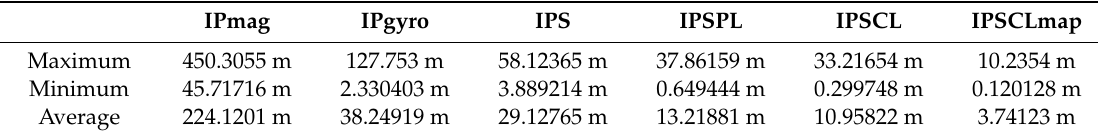
Figure 6. ( a ) Distance error for the ground-truth reference path as a function of the path; ( b ) cumulated distance error for the ground-truth reference path. Table 2. Maximum, minimum, and average distance error of